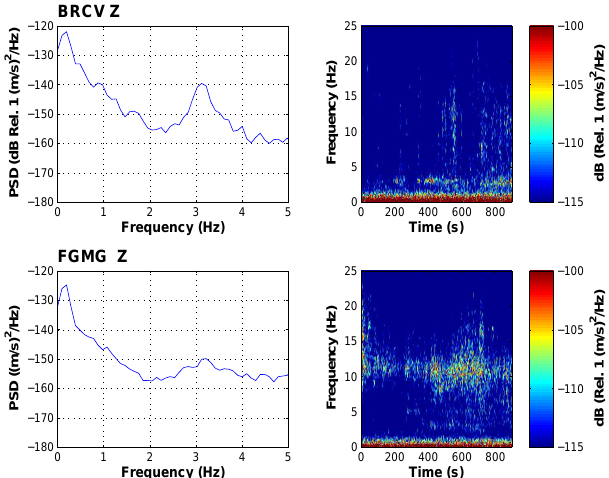
Fig. 11. Spectrogram (right), computed as in Fig. 6, of 15min win- dows of the vertical component of ground velocity for a harmonic tremor episode recorded on 8 March 2012 at 08:00UTC by BRCV (top) and FGMG (bottom) seismic stations as well as a detailed view of the power spectra (left) between 0 and